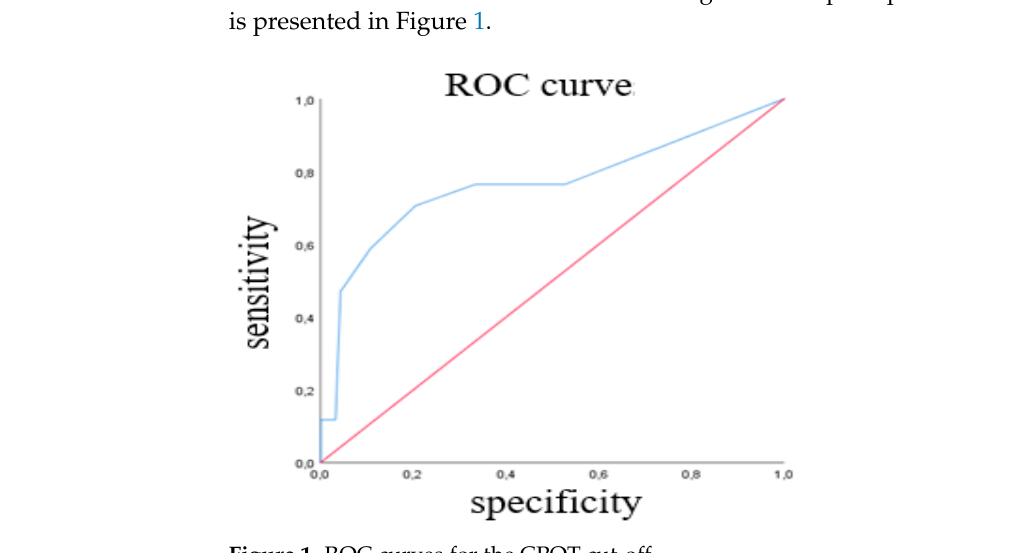
Figure 1. ROC curves for the CPOT cut-off. The ROC of Rater 1 (cid:48) s scores during NP showed good performance of the CPOT to classify patients with pain based on BPS > 5 (AUC = 0.764; SE = 0.077; 95% CI 0.613–0.915; p < 0.001) with a sensitivity of 71% and a specificity of 80%. A similar performance of